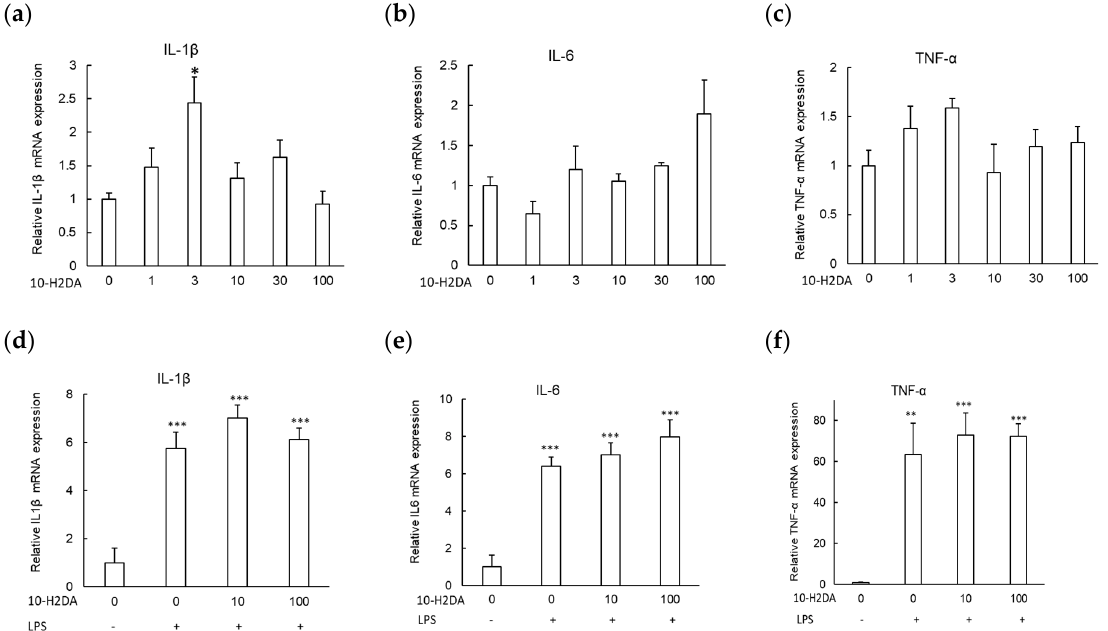
Figure 1. Effects of 10-H2DA on astrocytic expression of proinflammatory cytokines. ( a – c ) Astrocytes ( n = 4) were treated with 10-H2DA alone (0–100 µM) for 24 h. ( d – f ) Astrocytes ( n = 6) were treated with 10-H2DA (10 µM and 100 µM) for 24 h followed by LPS (10 ng/mL) for 3 h. Control values in ( a – f ) were obtained in the absence of LPS and 10-H2DA. The results are presented as means ± SEMs. Data were analyzed by one-way ANOVA with Tukey’s post hoc test; * p < 0.05 versus control cells. **: significance at 0.01, ***: significance at 0.001 compared with untreated cells. LPS treatment is indicated by + and absence of LPS is indicated by -.